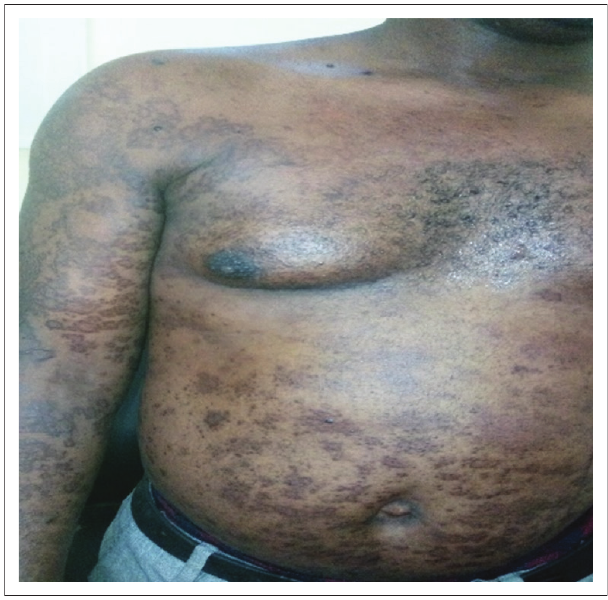
FIGURE 1: Anterior view of the skin lesion diagnosed as Kaposi sarcoma and Molluscum